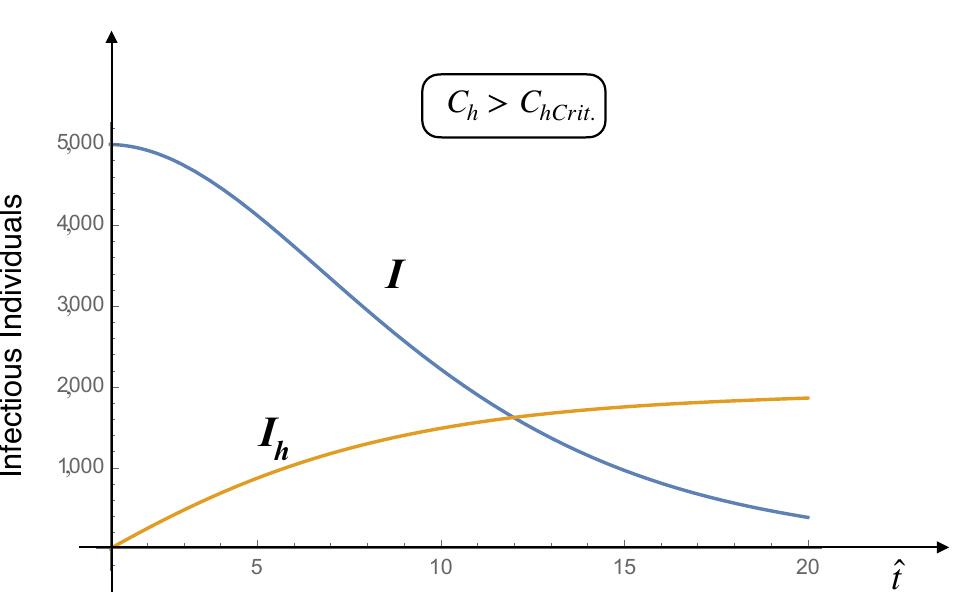
Figure 17. Infectious people and infectious hospitalised people vs. time- C h > C HCrit . . Independently of the initial size of the susceptible population, the disease can never cause a proper epidemic outbreak. The values of the parameters are: β = 0, k 1 = 0.00001, ρ = 0.0001, K 1 = 150,000, γ = 0.0001, σ = 2.7651, and C h =